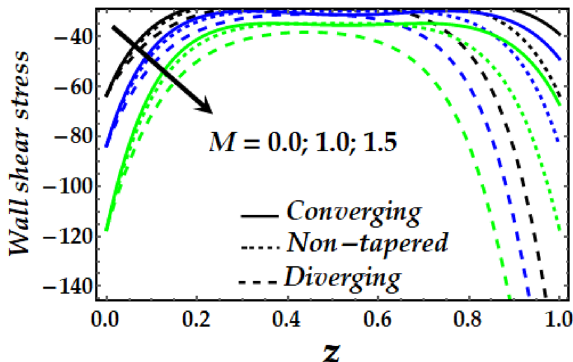
Figure 21. Wall shear stress against distinct values of M .